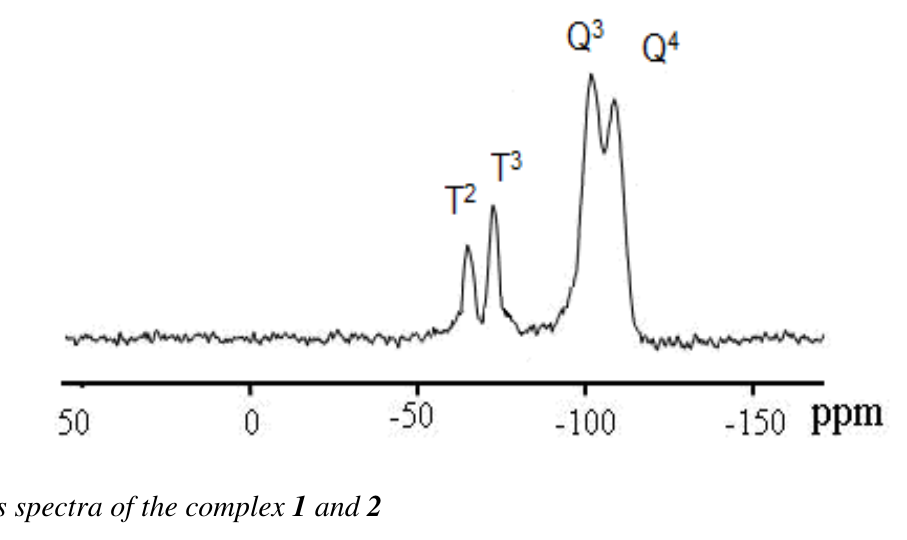
Figure 6. 29 Si CP/MAS NMR spectrum of X2 , prepared by condensate of complex 2 with 10 equivalent of Si(OEt) 4